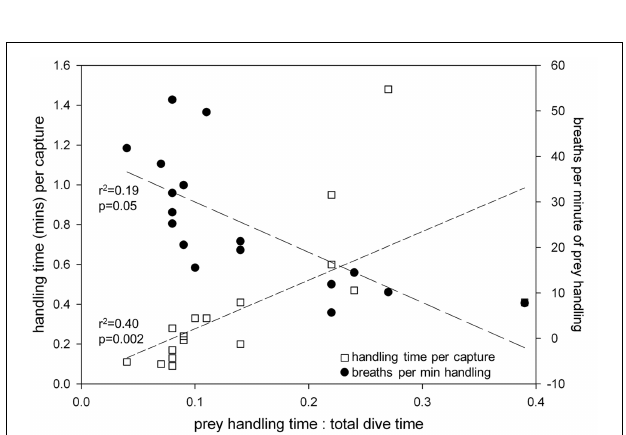
FIGURE 7 | Prey captures per dive and capture rates (number of prey captured h − 1 ) increased significantly with number of prey encountered by leatherback turtles ( Dermochelys coriacea ) foraging in the Northwest Atlantic Ocean off Nova Scotia, Canada.